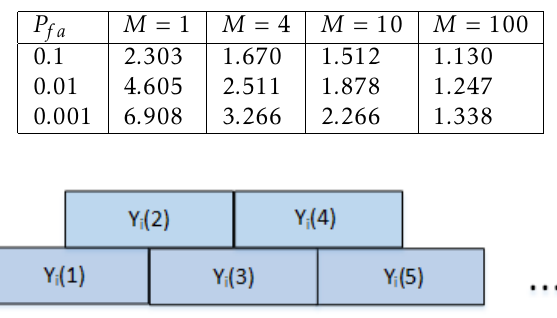
Figure 3. Illustration of 50% overlapping when there are L overlapping blocks and the length of one block is M